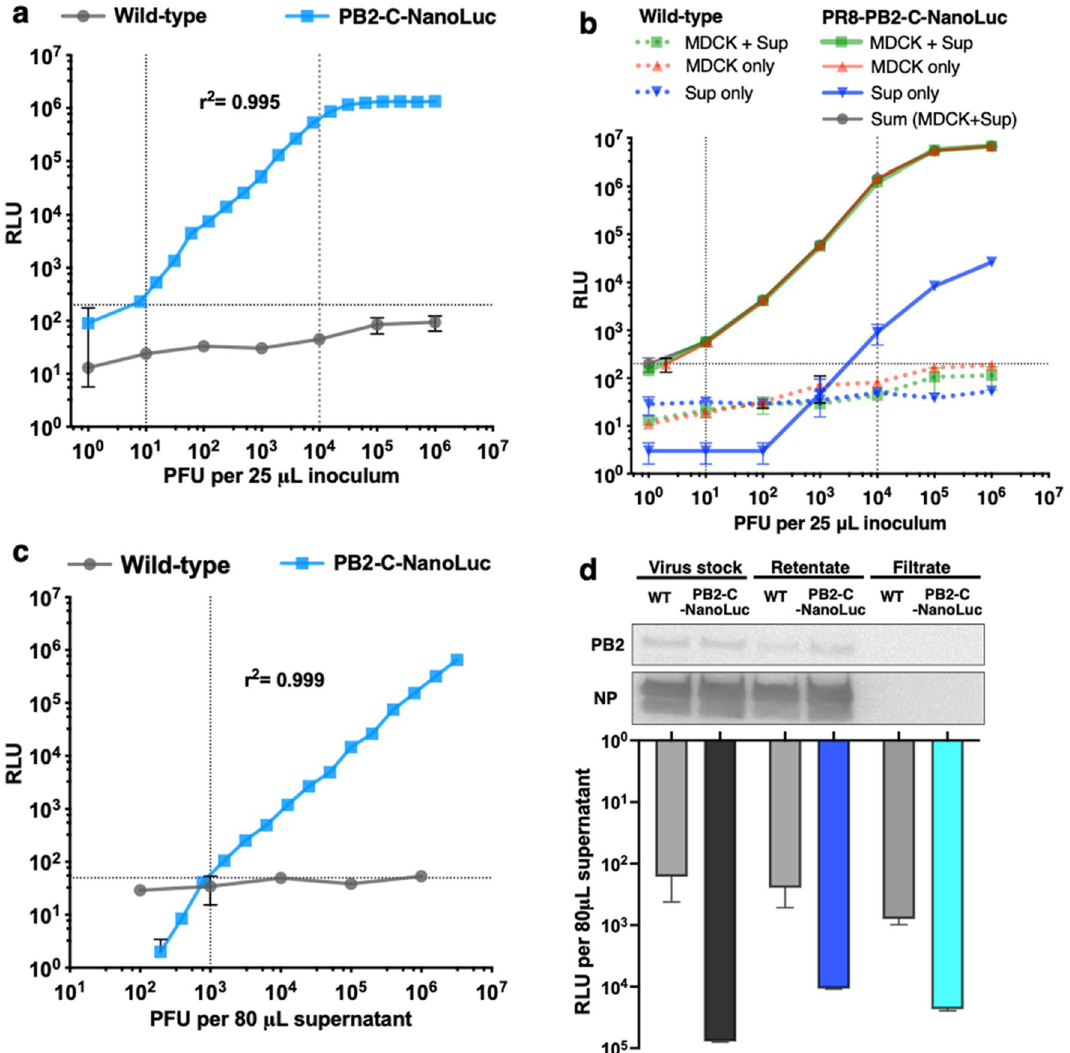
Figure 8. Linear detection range of PB2-C-NanoLuc IAV. Results reported as mean ± SD relative luciferase units (RLU) for triplicate measurements. ( a ) Linear detection range of PB2-C NanoLuc IAV in MDCK cells. Serially diluted samples (25 μL each) of wild-type or PB2-C-NanoLuc IAV were inoculated onto MDCK cells in white 96-well plates. At 12 h after inoculation, equal volume of luciferase substrate (80 μL) was added and luminescence was measured from MDCK cells and supernatant combined. There was strong correlation between measured luciferase activity vs infectious IAV titer from 10 1 to 10 4 PFU per 25 μL of inoculum (r 2 , 0.995; p < 0.0001). ( b ) Comparison of luciferase activity between MDCK cells and supernatants of MDCK cultures infected with PB2-C-NanoLuc IAV. To determine the source of the luciferase activity in the infected MDCK cultures, we separated MDCK cells and culture supernatants and measured the luciferase activity separately. At 12 h after inoculation of wild-type or PB2-C-NanoLuc IAV onto MDCK cells, luciferase activity was measured from MDCK cells and supernatant combined (squares; same method as in ( a )), MDCK cells only (triangles; replacing with 80 μL PBS before adding 80 μL substrate), and supernatant only (upside-down triangles; adding 80 μL substrate); sum of data from MDCK only and supernatant only (circles). Within the linear range of detection (10 1 –10 4 PFU per 25 μL inoculum), the luciferase activity from MDCK cells and supernatants combined was most comparable to that from MDCK cells alone. ( c ) Linear detection range of PB2-C NanoLuc IAV in supernatants. Luciferase activity of serially diluted 80 μL of wild-type or PB2-C- NanoLuc IAV was measured without infection to MDCK cells (same method of supernatant only as in ( b )). Luciferase activity correlated with IAV PFU concentration linearly at PFU > 10 3 per 80 μL supernatant (r 2 , 0.999; p < 0.0001). ( d ) Stocks of wild-type and PB2-C-NanoLuc IAV were filtered (100 kDa cutoff), and the retentates and filtrates were adjusted to the original volume (1 mL) and analyzed via luciferase assay and Western blot for PB2 and nucleoprotein (NP) as a marker for the presence of IAV. Cropped blots are displayed. Full-length blots are presented in Supplementary Fig.